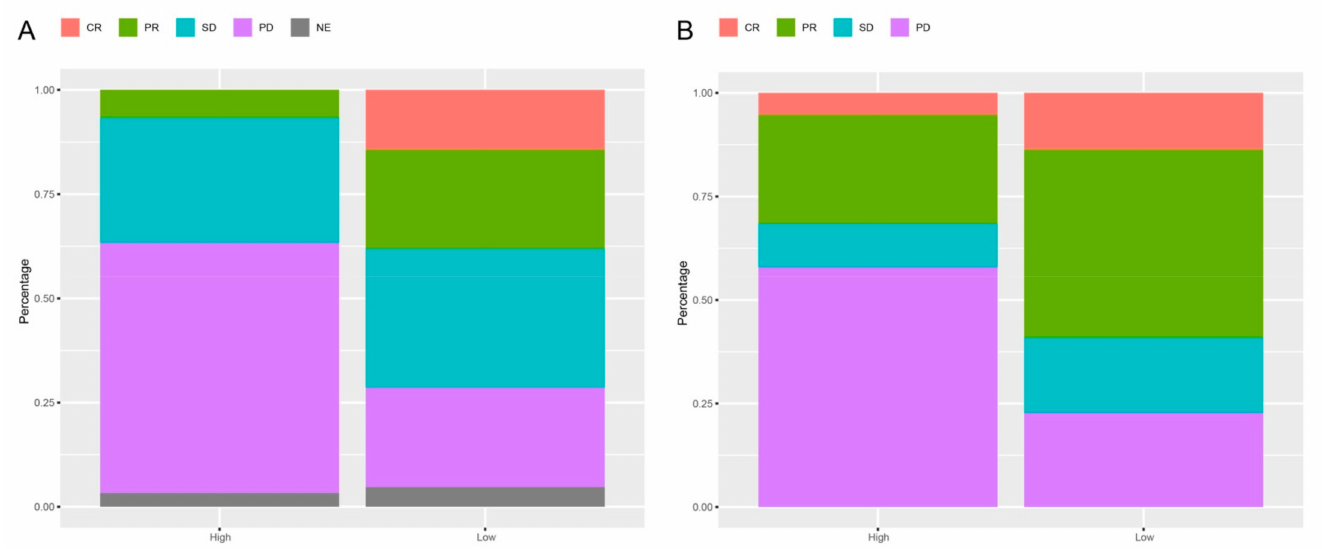
Figure 7. Response rates in the high-risk (high) versus the low-risk (low) groups in advanced melanoma patients treated with anti- PD-1 monotherapy based on the 15 lncRNAs signature. ( A ) Response rates based on the 15 lncRNAs signature in advanced melanoma patients treated with anti-PD-1 monotherapy in the training cohort. ( B ) Response rates based on the 15 lncRNAs signature in advanced melanoma patients treated with anti-PD-1 monotherapy in the validation cohort. CR: complete response; PR: partial response; SD: stable disease; PD: progressive